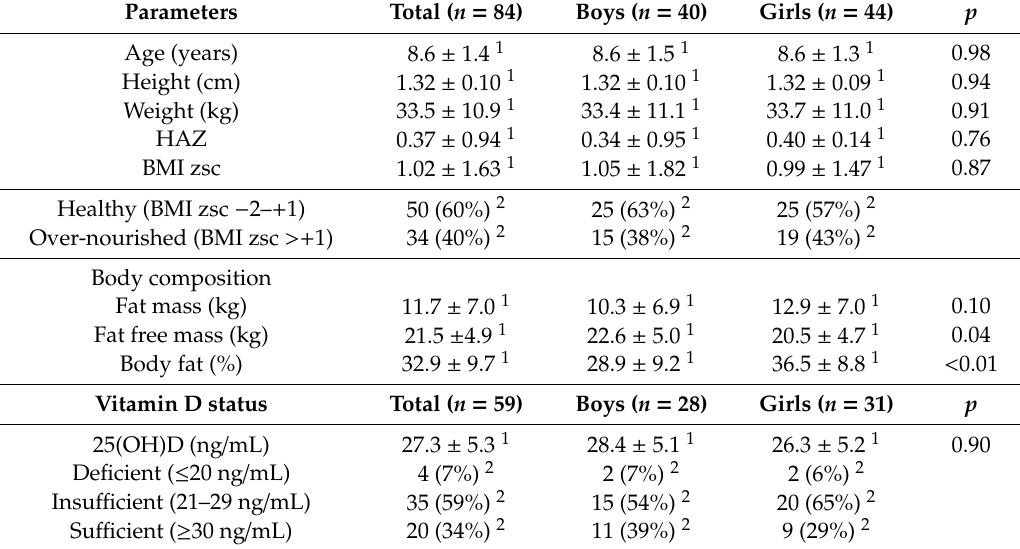
Table 1. Participant characteristics for total group and comparison between